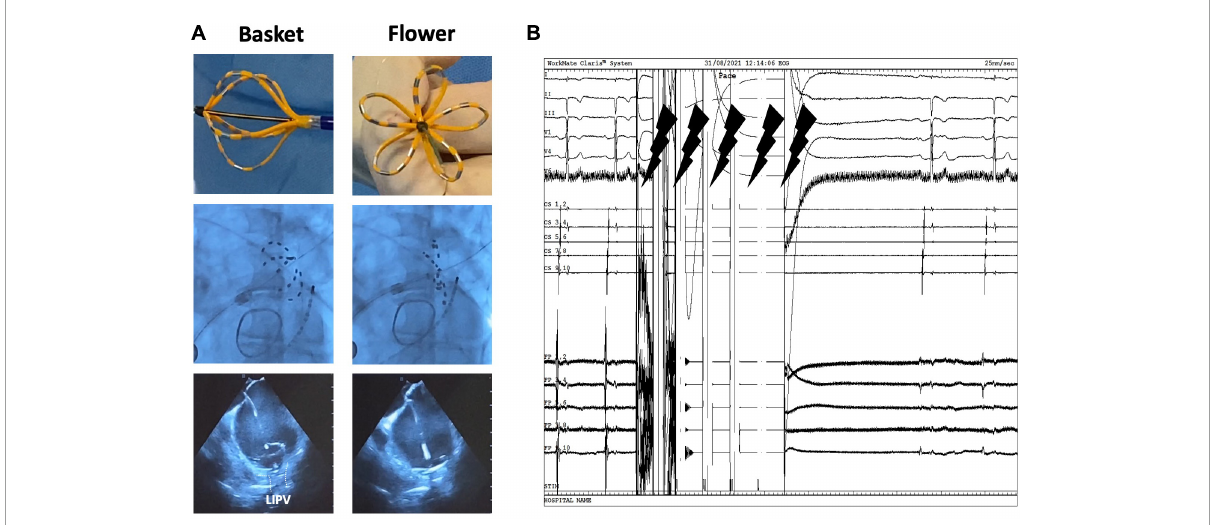
FIGURE1 Pulsed field ablation system and workflow. (A) (In order from top to bottom) Physical, fluoroscopy, and echocardiogram view of the FARAWAVE catheter in both basket and flower shapes. (B) Electrograms showing biphasic waveform application with five